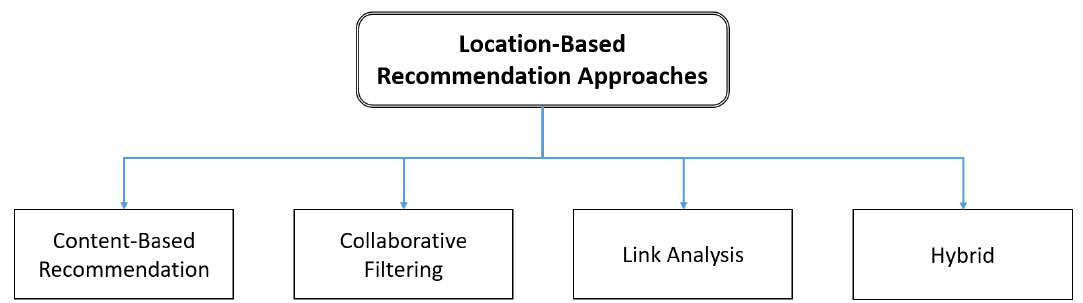
Figure 3. Recommendation methodologies used by location-based recommendation systems.